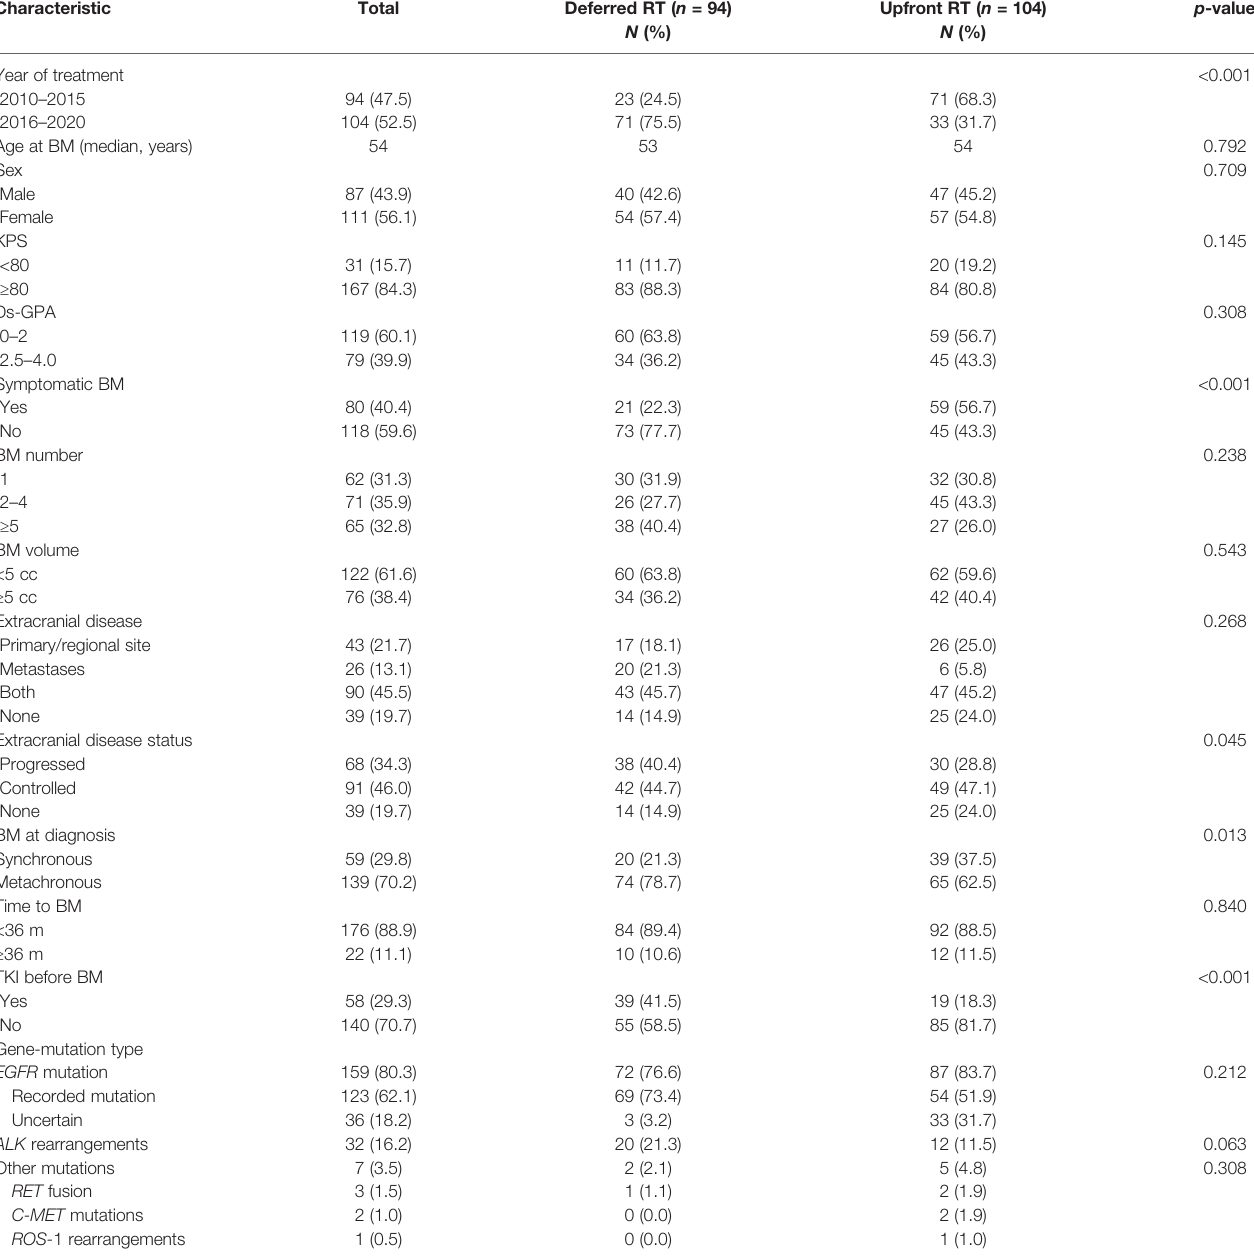
TABLE 1 | Clinical characteristics of patients in the deferred RT and upfront RT groups.